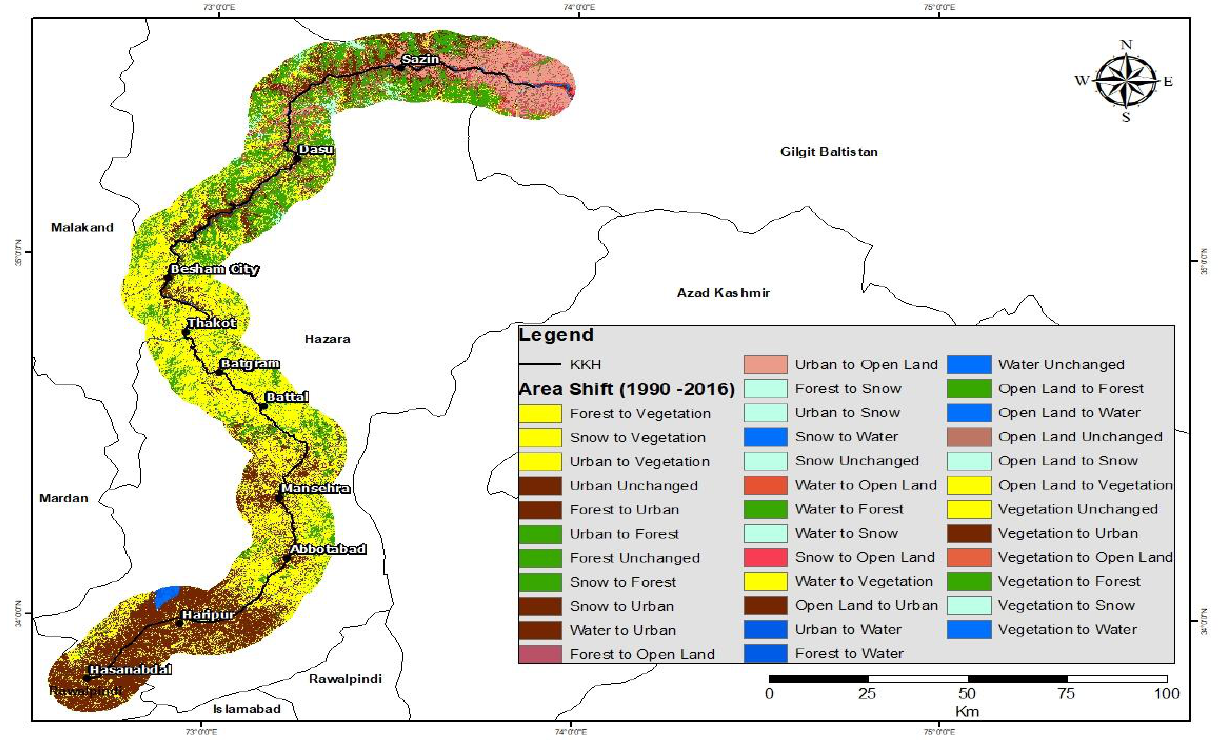
Figure 5 Forest Cover Shift (1990 to